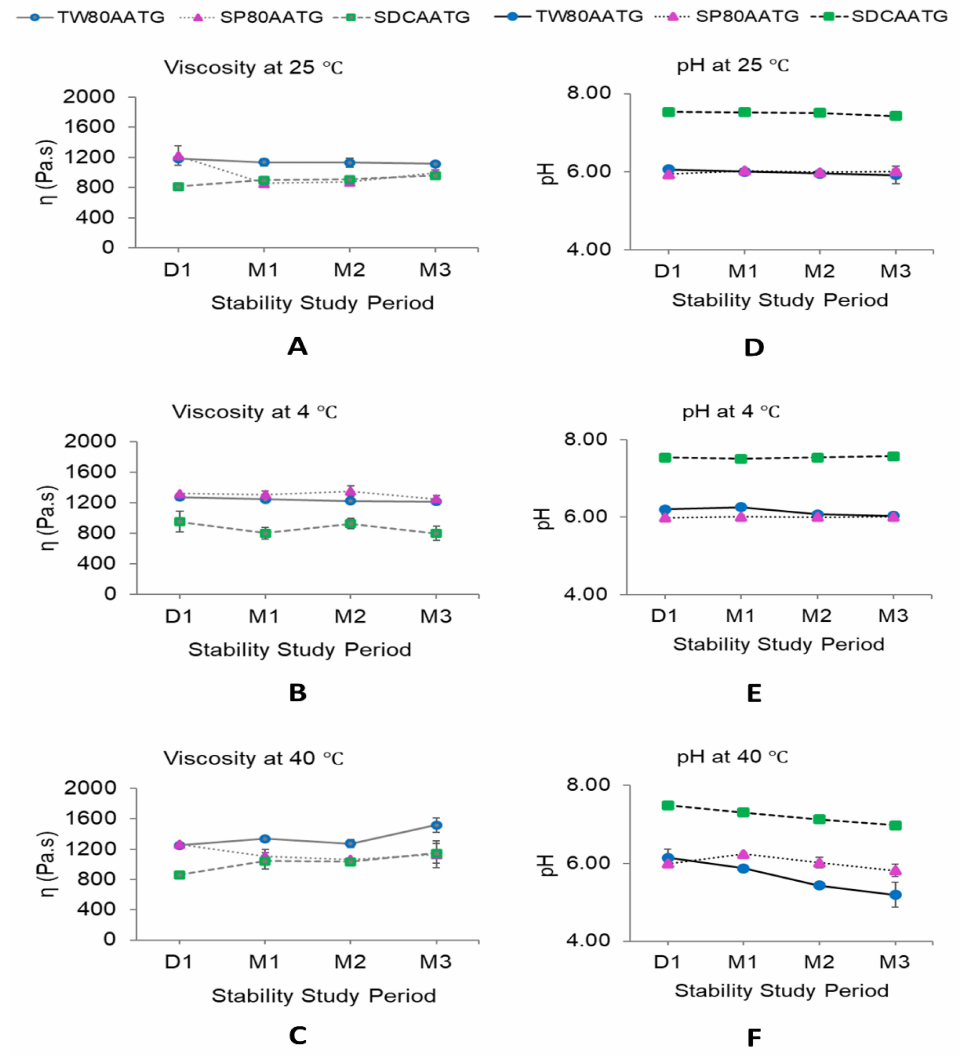
Figure 6. Dynamic viscosity and pH of AATGs during stability study period. ( A ) Viscosity at 25 ◦ C, ( B ) viscosity at 4 ◦ C, ( C ) viscosity at 40 ◦ C, ( D ) pH at 25 ◦ C, ( E ) pH at 4 ◦ C and ( F ) pH at 40 ◦ C. Each value represents mean ± SD with n =